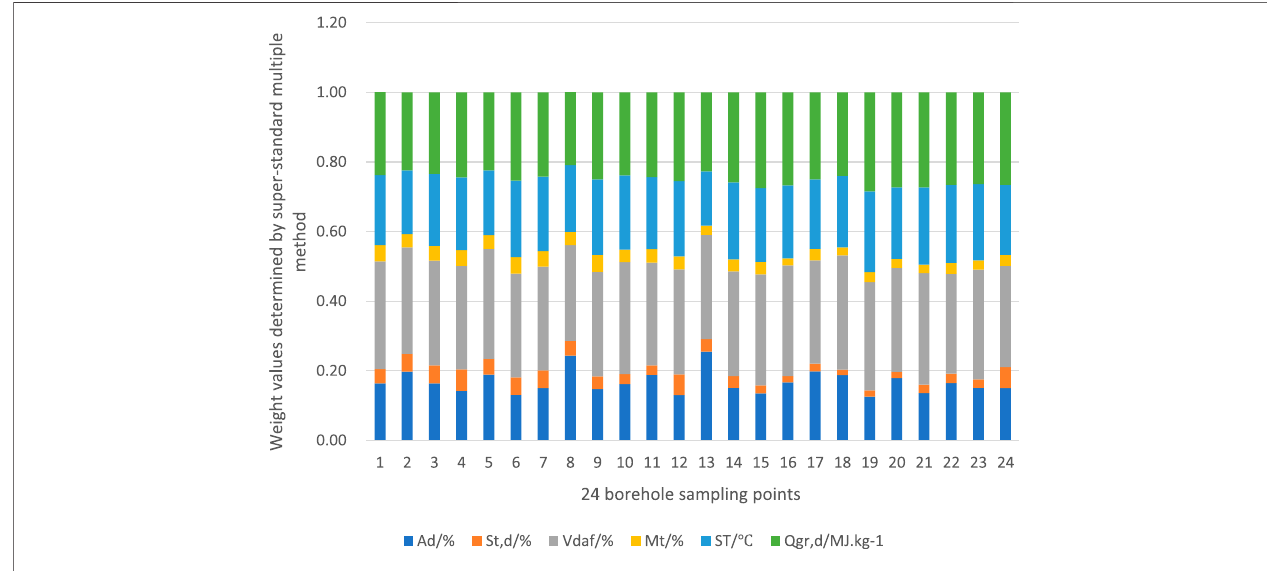
FIGURE 5 | Weight values determined by super-standard multiple